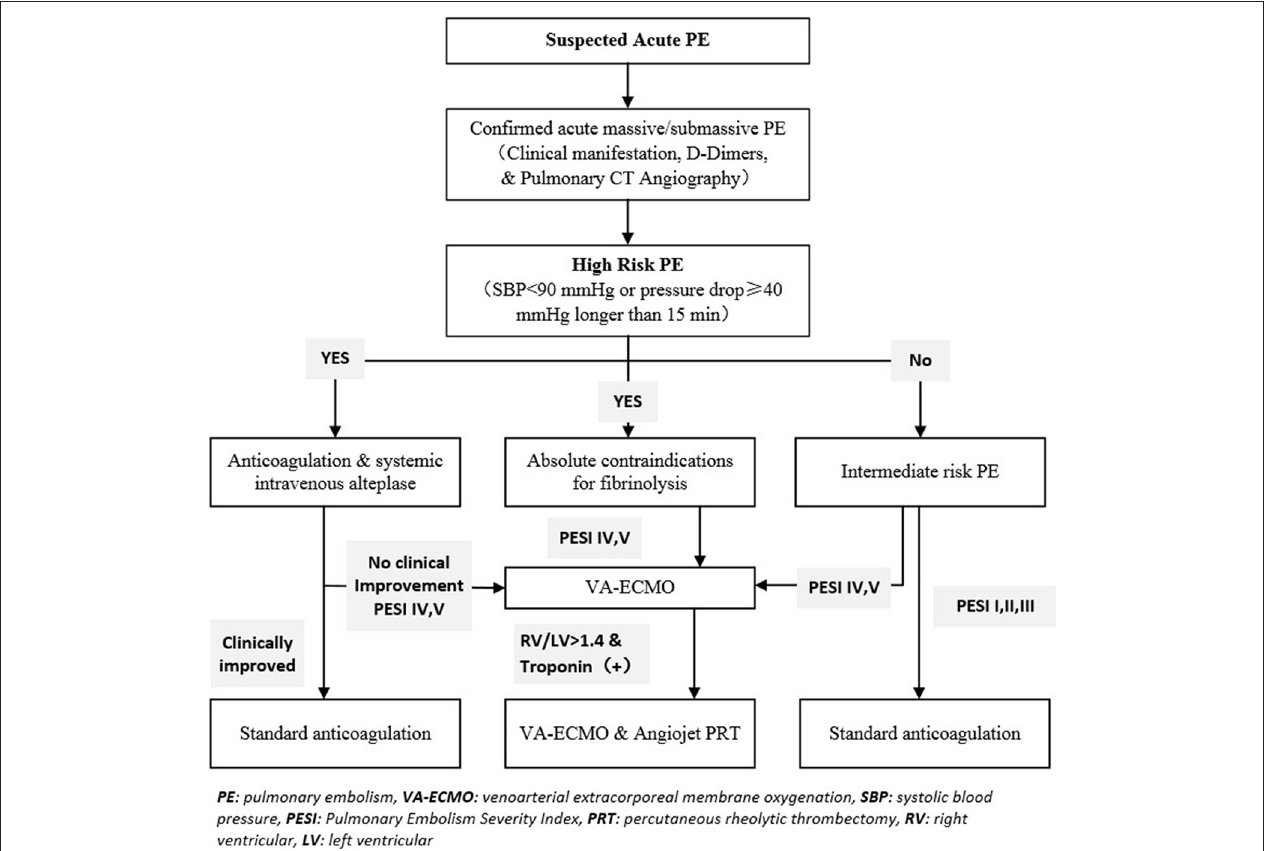
FIGURE 1 | Our PE rapid response team’s criteria select patients with massive or submassive PE candidates for VA-ECMO and pulmonary mechanical thrombectomy (AngioJet PRT) candidates. PE, pulmonary embolism; VA · ECMO, venoarterial extracorporeal membrane oxygenation; SBP, systolic blood pressure; PESI, Pulmonory Embolism Severity Index; PRT, percutaneous rheolytic thrombectomy; RV, right ventricular; LV, left